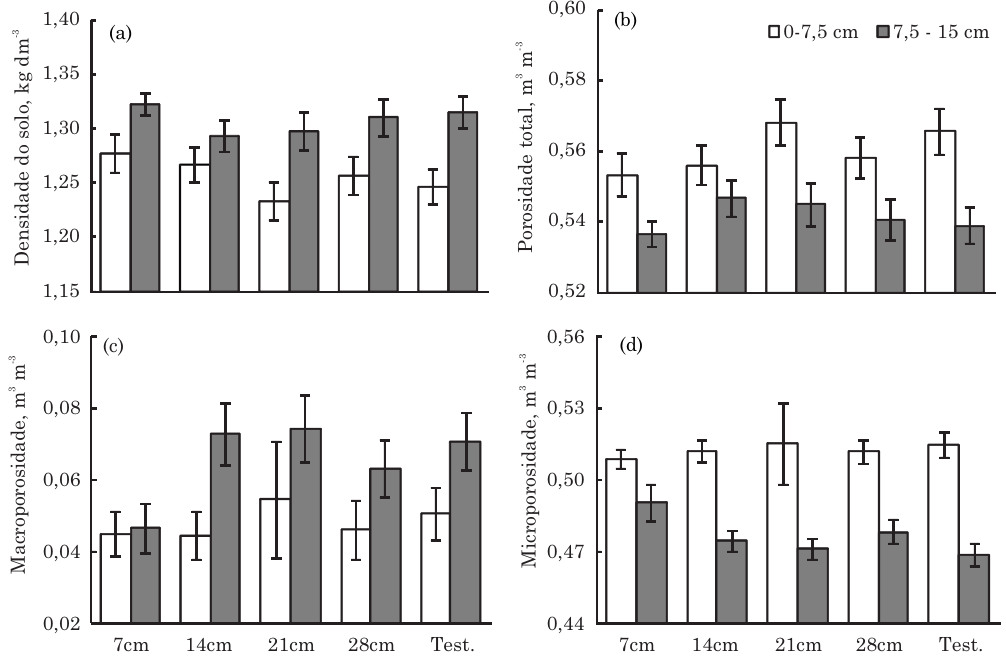
Figura 1. Densidade do solo (a), porosidade total (b), macroporosidade (c) e microporosidade (d) para os tratamentos de 7, 14, 21, 28 cm e testemunha (Test), nas profundiades de 0,0-7,5 e 7,5-15,0 cm. A sobreposição do intervalo de confiança da média índica ausência de diferença estatística entre os valores